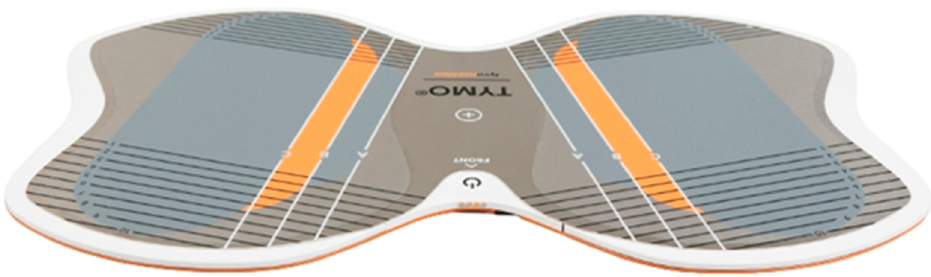
Figure 2. Posturographic TYMO ® platform [33].